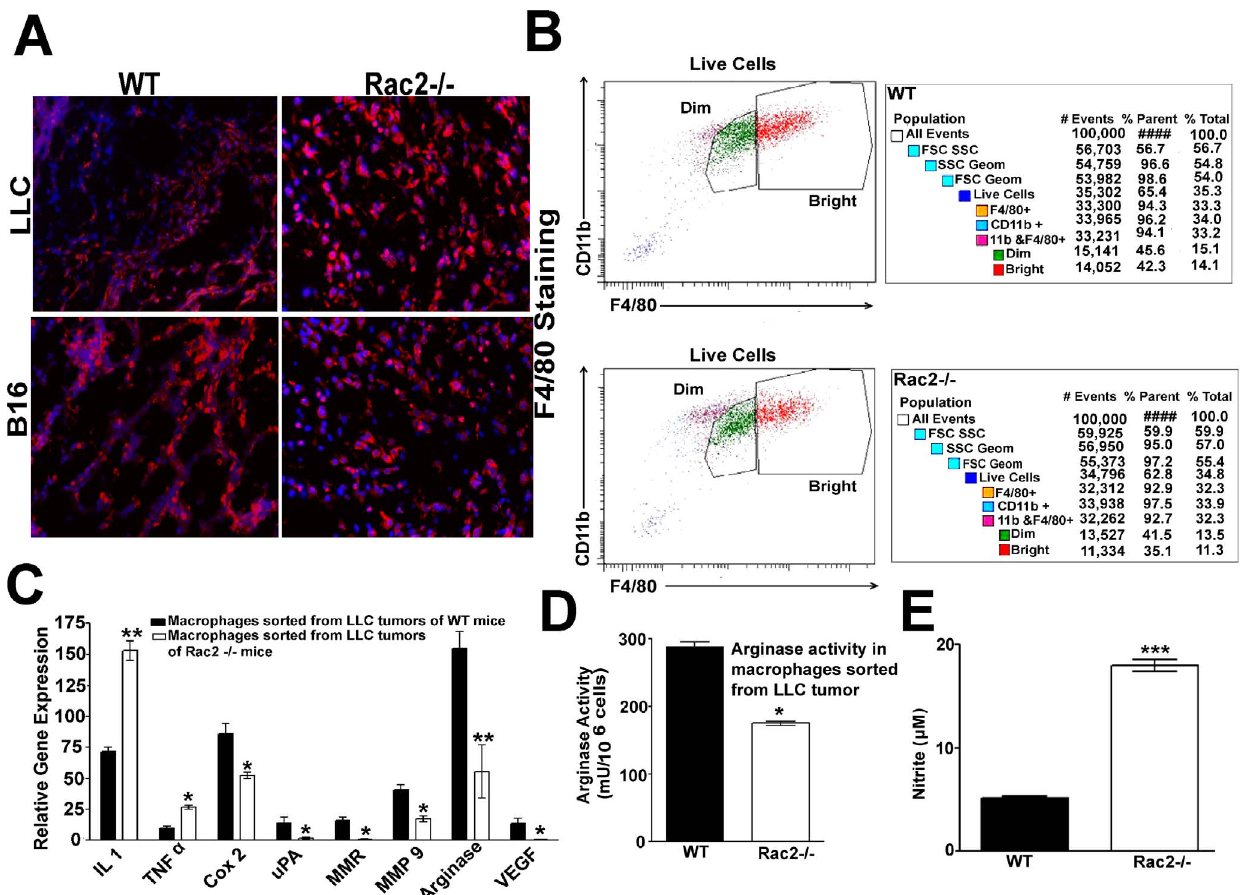
Figure 4. Rac2 promotes M2 macrophage polarization with no substantial change in macrophage recruitment. (A) Identification of F4/ 80 + macrophages by immunofluorescence microscopy in the frozen sections of LLC and B16 tumors stained with antibodies against F4/80 and imaged by fluorescence microscopy. The average no. of macrophages per HPF for 3 different experiments were 42 6 8, (WT) 38 6 6 (Rac2-/-) for LLC tumors and 50 6 5, (WT) 45 6 10, (Rac2-/-) for B16 tumors. Macrophages were counted blindly by 3 individuals in 5-10 randomly chosen fields and data is representative of three independent experiments with 4 mice. (B) Figure represents FACS data showing the quantification of CD11b and F480 + macrophages infiltrated in LLC tumors implanted in WT and Rac2-/- mice. Experiment was repeated 4-5 times with 3-4 mice in each group and similar results were obtained. (C) Quantitative PCR analysis of mRNA for M1, M2 specific genes in the macrophages sorted from LLC tumors grown in WT and Rac2-/- mice (n=3–4) as described in Methods. Values are mean 6 SEM. Statistical significance is assessed by two sample t -test where *denotes P , 0.05, ** denotes P , 0.01 and *** denotes P , 0.001. (D) Arginase activity was measured in macrophages sorted from LLC tumors injected in WT and Rac2-/- mice as described in Methods. (E) Nitrite production in macrophages sorted from LLC tumors injected in WT and Rac2-/- and stimulated with 10 ng/ml LPS for 24 h. Supernatants were collected, and nitrite concentration was measured as described in Methods. Results are mean 6 SEM (n=3–4 mice) for 3 independent experiments performed in triplicate (P , 0.05 for arginase activity and P , 0.001 for nitrite assay; student’s t